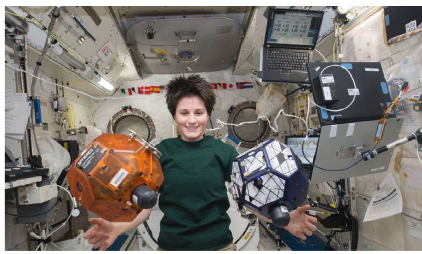
Figure 1: ESA astronaut S. Cristoforetti in microgravity onboard of the International Space Station.